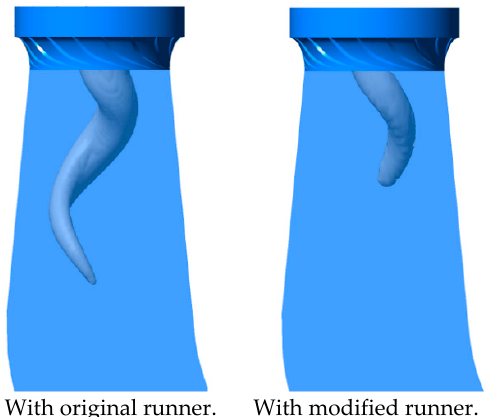
With original runner. With modified runner. Figure 7. Vortex rope structured by Q-criterion.